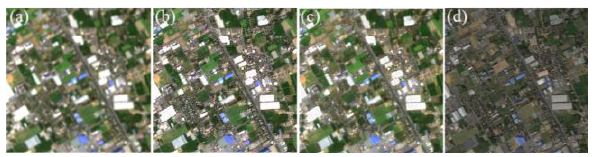
Figure 14. Test results of EXP2 for Ichihara image (a) LR S2 image (10.0 m) (b) Output (2.5m) (c) Google Earth image (18/12/2020).